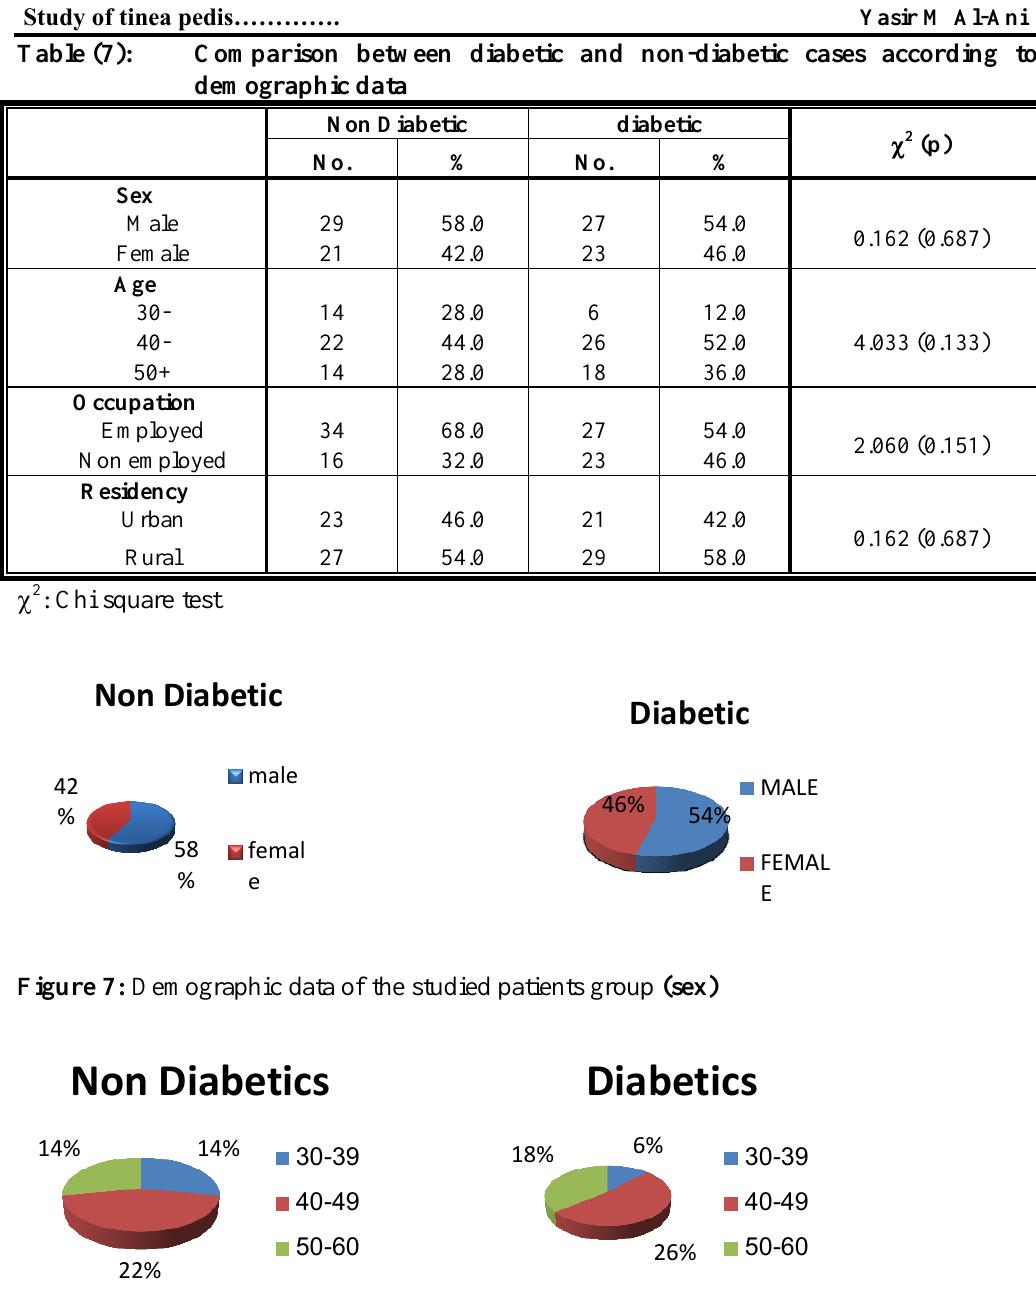
Figure 8: Demographic data of the studied patients group (age) e. Diabetic profile: